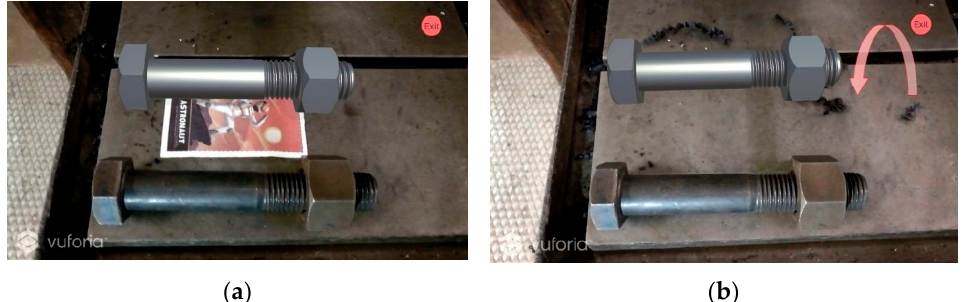
Figure 11. Marker-less AR scene developed by the authors in the University of Bologna mechanical workshop ( a ) with marker, ( b ) marker less.